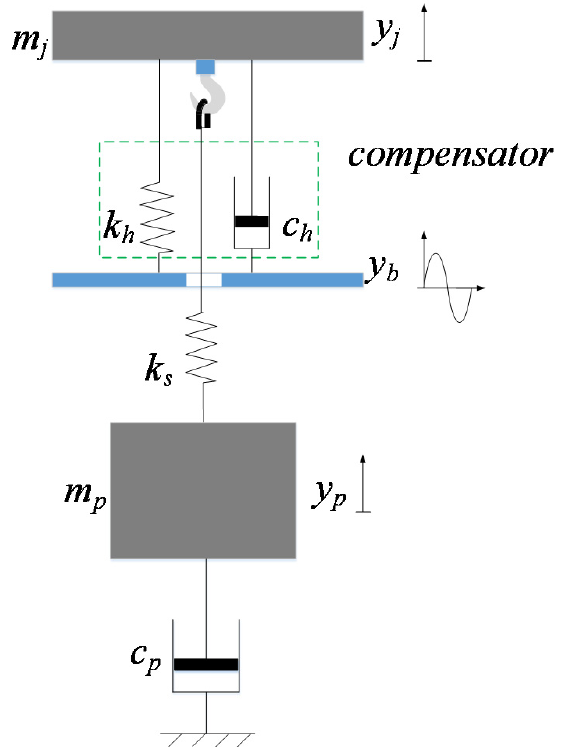
Figure 4. Schematic diagram of the strand jack lifting system.